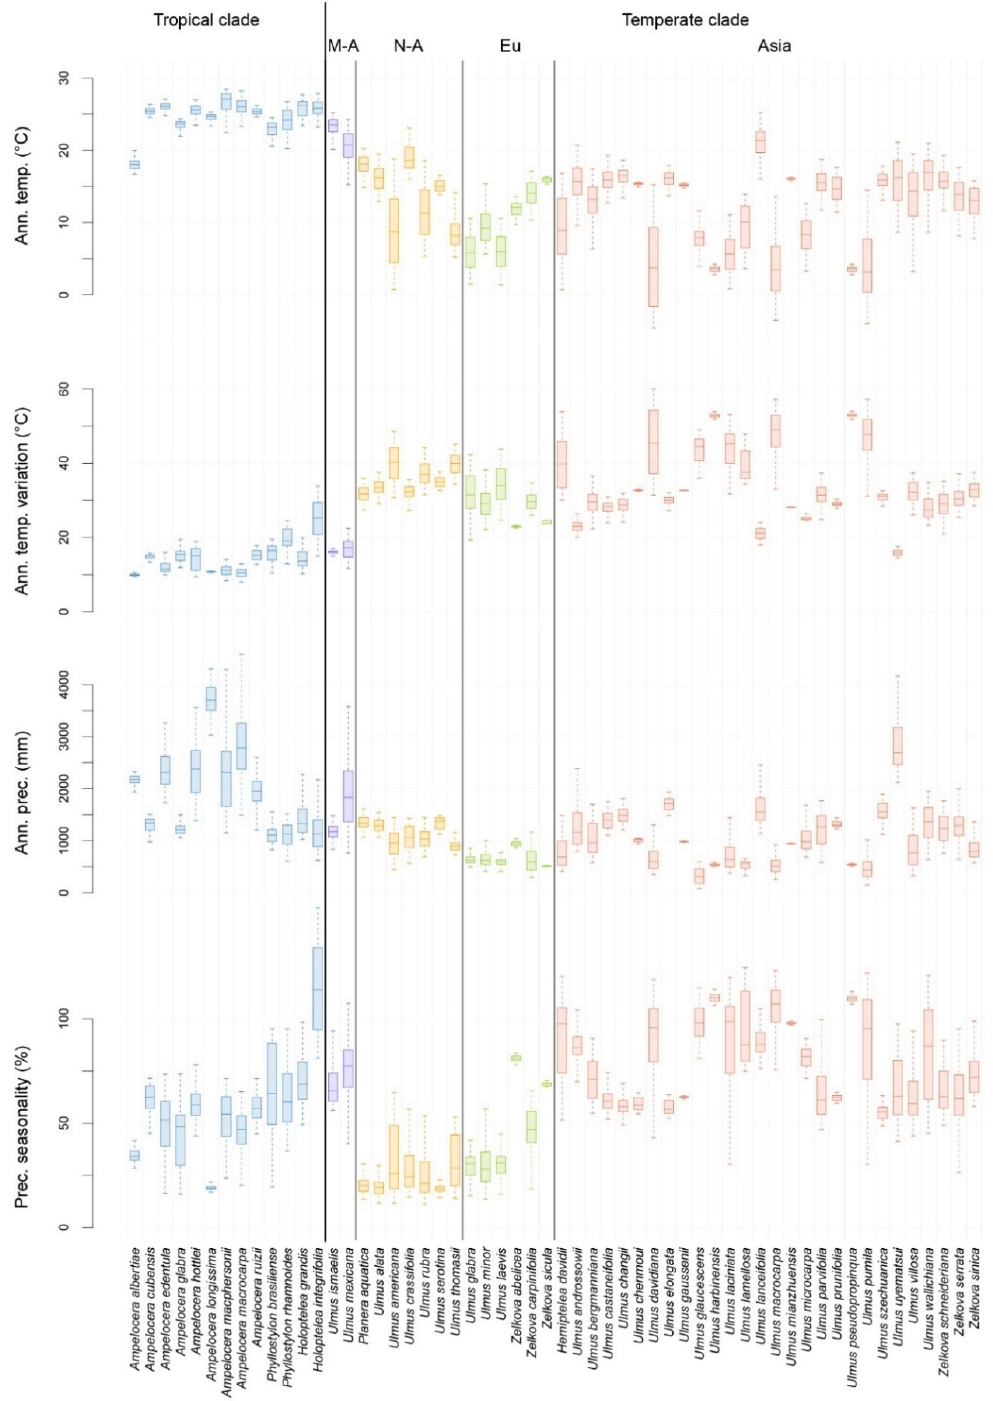
Figure 4. Macroclimatic preferences for each species of the Ulmaceae family according to their natural distribution and for a selection of four climatic variables: mean annual temperature ( ◦ C), mean annual temperature variation (maximum temperature of the warmest month—minimum temperature of the coldest month, ◦ C), mean annual precipitation (mm) and precipitation seasonality (variation in monthly precipitation totals over the course of the year, %). The species are presented in the following order from left to right: tropical clade and temperate clade, further divided in Mesoamerica (M-A), North America (N-A), Europe (Eu), and Asia. These five groups are indicated by different